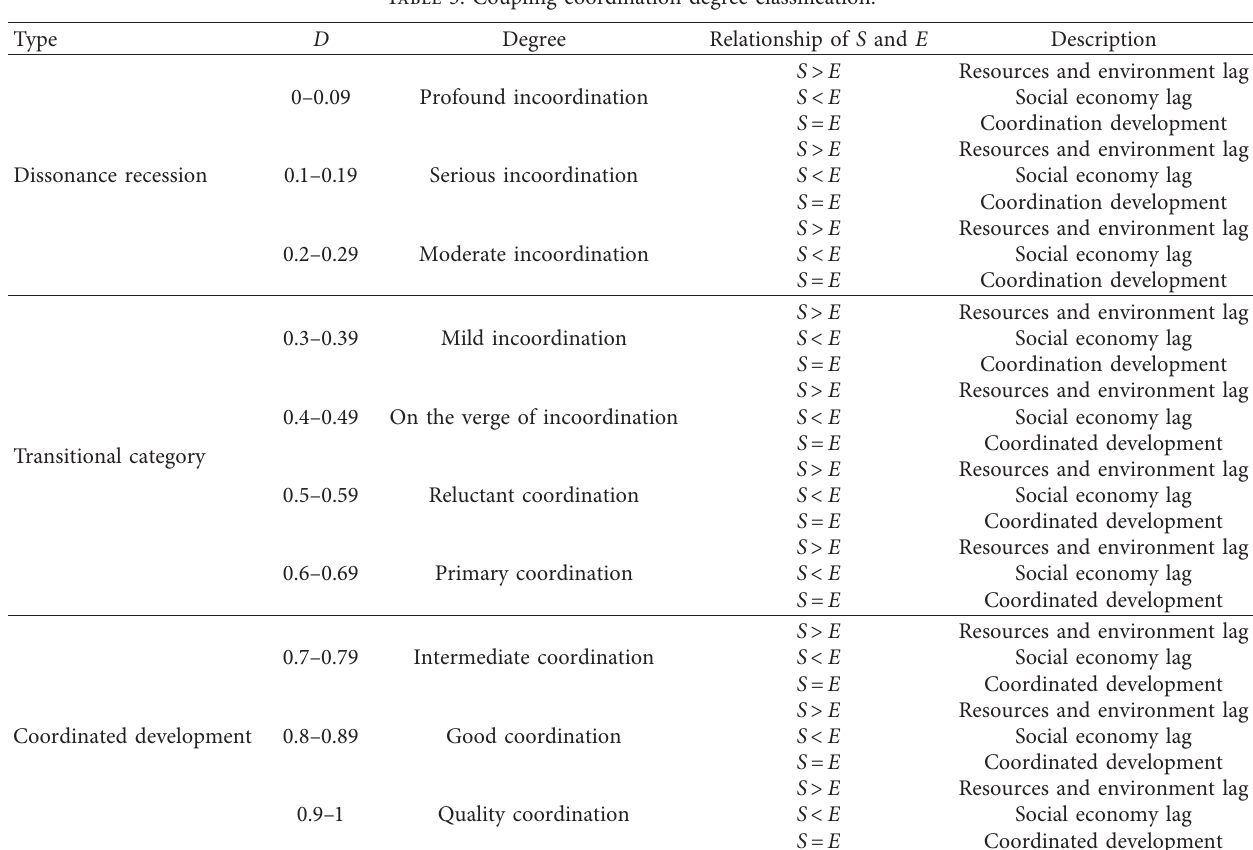
Table 3: Coupling coordination degree